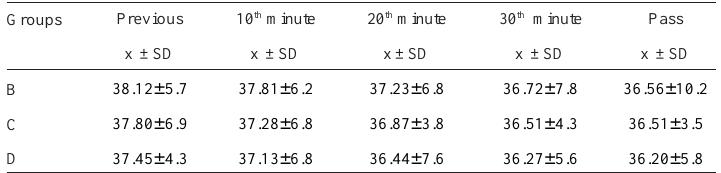
Table 4. Oral temperatures (°C) Groups